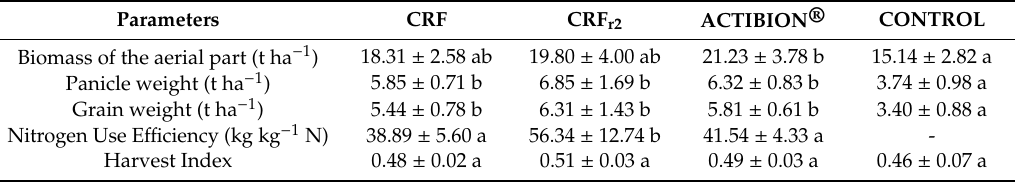
Table 4. Field harvest comparison of the growth parameters and grain yield of Oryza sativa var. bomba between the di ff erent fertilizer treatments applied: CRF, CRF r2 , and ACTIBION ® (CRF and ACTIBION ® : 140 NFU; CRF r2 : 112 NFU) compared to the CONTROL (no fertilizer applied). Values are means ± SD, n = 4 (pools of plants in 1 m 2 ) at the end of the culture, corresponding to 82 days after applying the